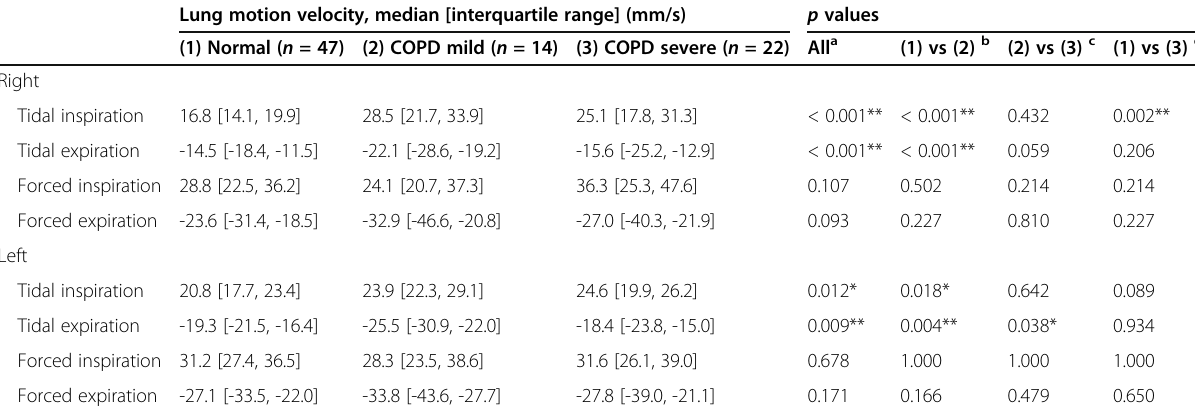
Table 4 Lung motion velocity in tidal and forced inspiration and expiration phases among normal, chronic obstructive pulmonary disease (COPD) mild, and COPD severe groups Lung motion velocity, median [interquartile range] (mm/s) p values (1) Normal ( n = 47) (2) COPD mild ( n = 14) (3) COPD severe ( n = 22) All a Right